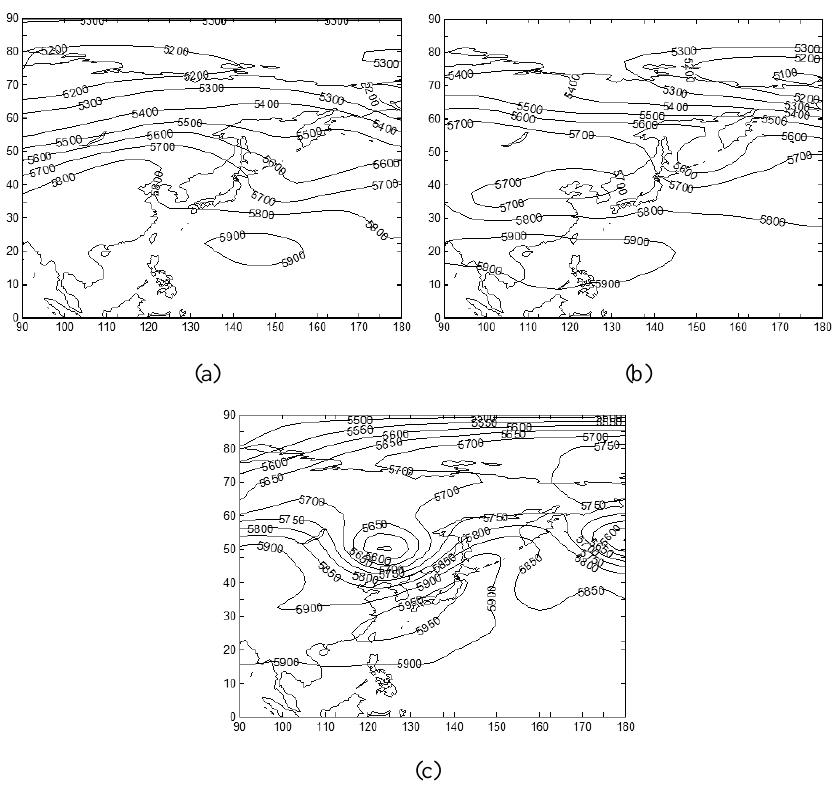
Fig. 6. The summer SH potential fields of (a) the high equilibrium and (b) the low equilibrium in 2003 reconstructed before combination with b 1 = − 0 . 3, and (c) after combination with b 1 = 0 .